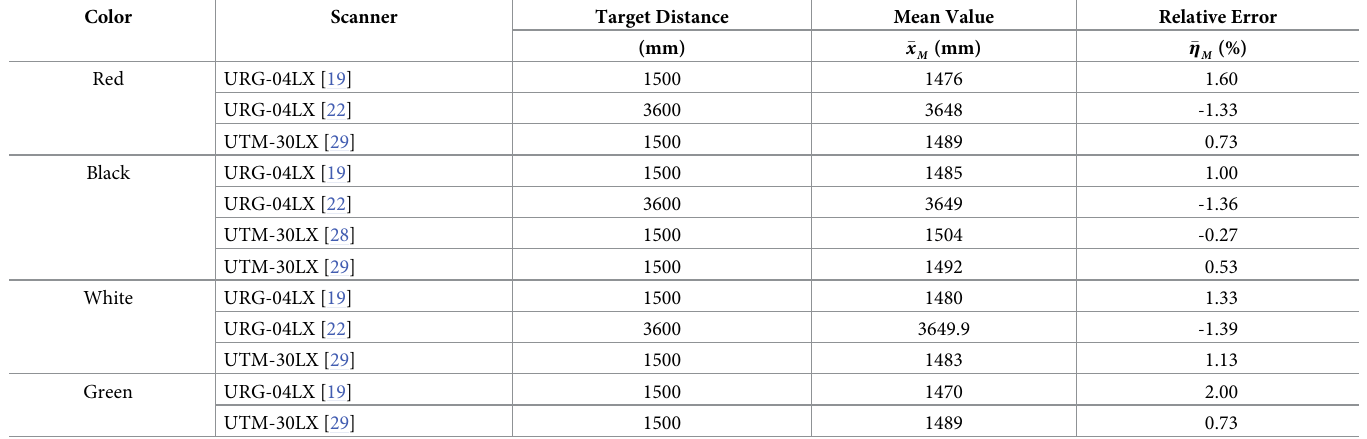
Table 9. Comparison of impact of color